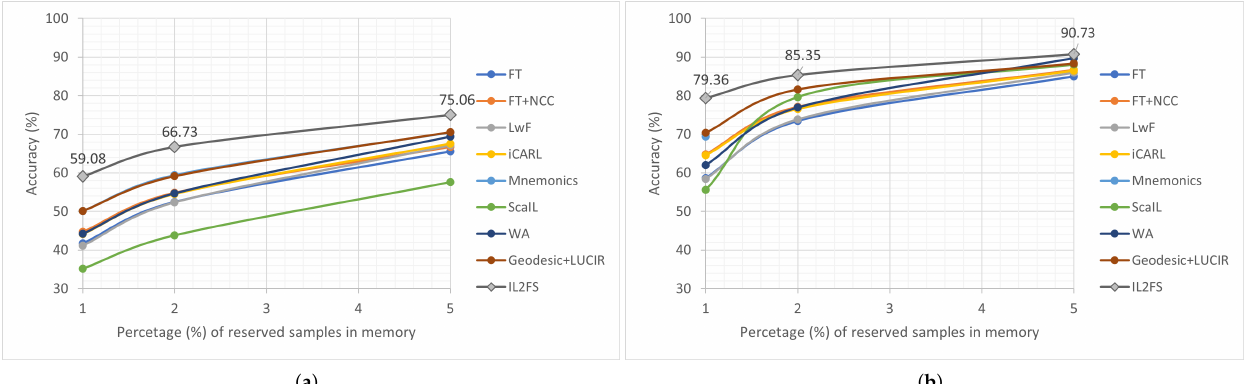
Figure 4. Effect of the number of reserved samples in memory: ( a ) DREAMER and ( b ) DEAP.